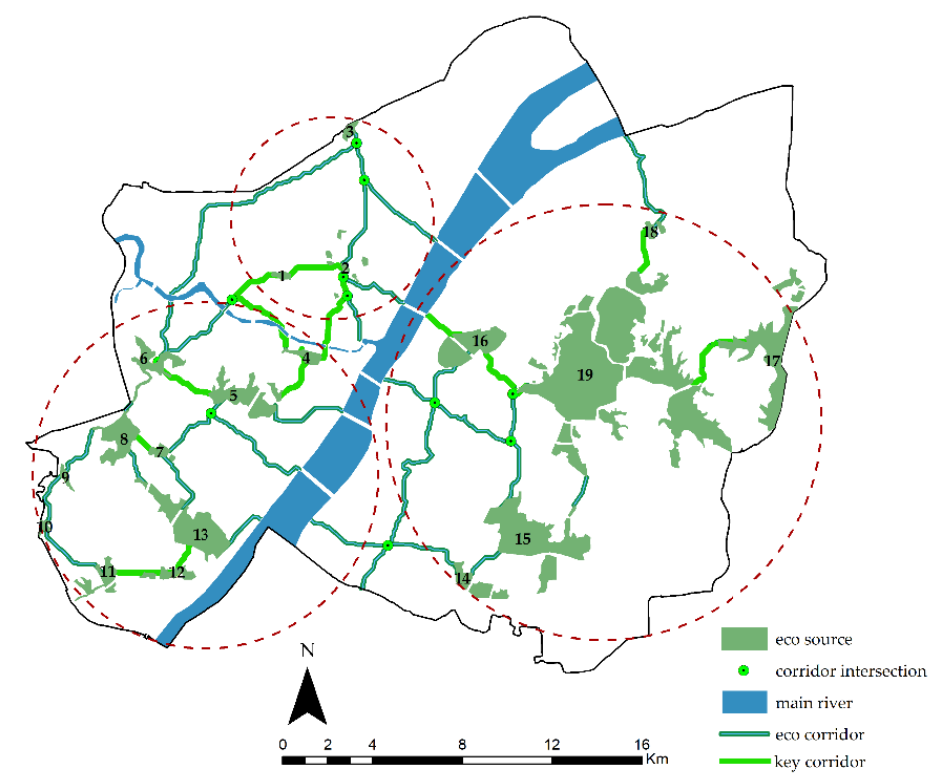
Figure 10. Distribution of key corridors.